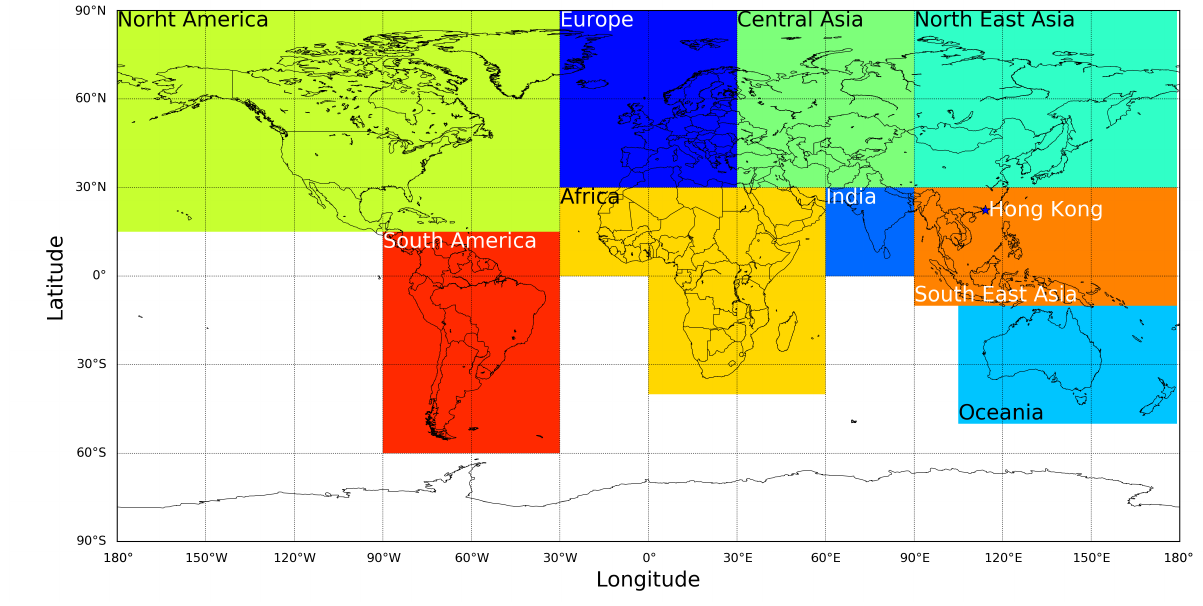
Figure 1. Emission source regions of biomass burning in the model. The asterisk marker indicates the location of Hong